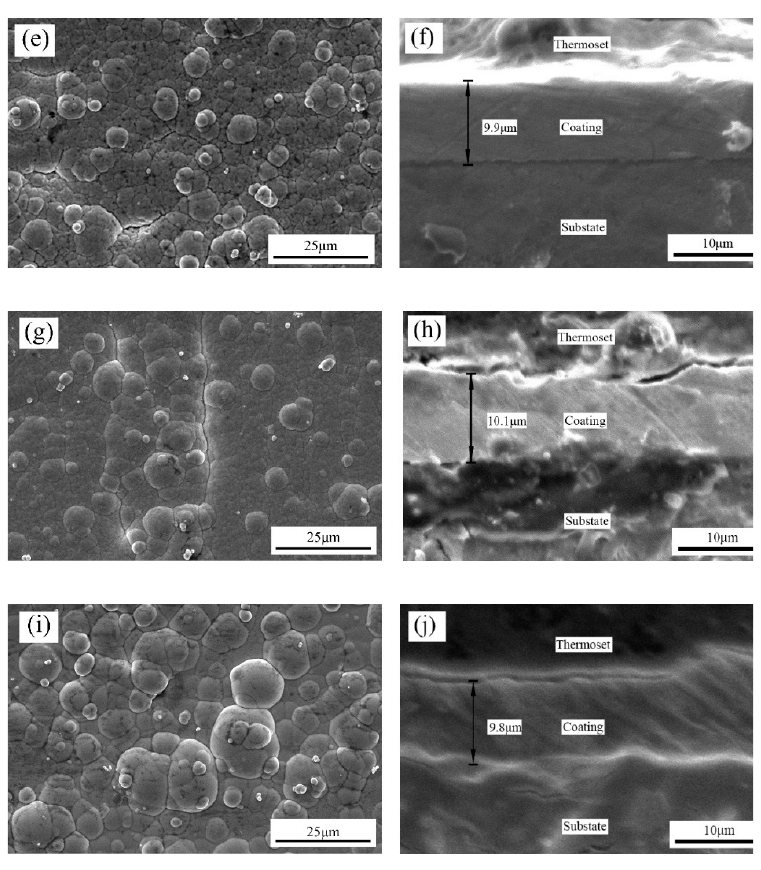
Figure 6. Surface and cross-sectional morphologies of coatings prepared with different SiC particle concentrations: ( a , b ) 2, ( c , d ) 4, ( e , f ) 6, ( g , h ) 8 and ( i , j ) 12 g/L.